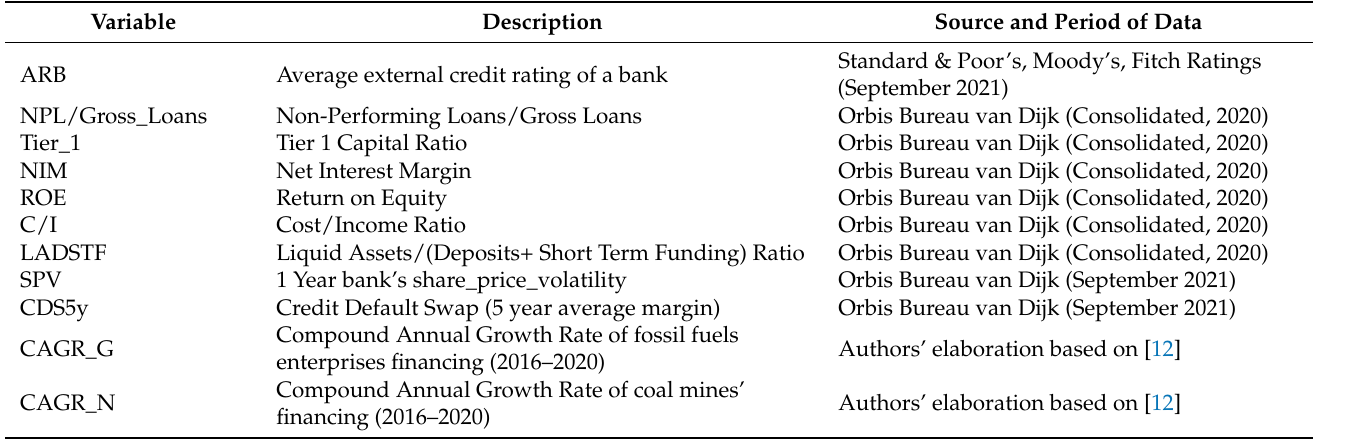
Table 2. Description of explanatory variables used in the study.